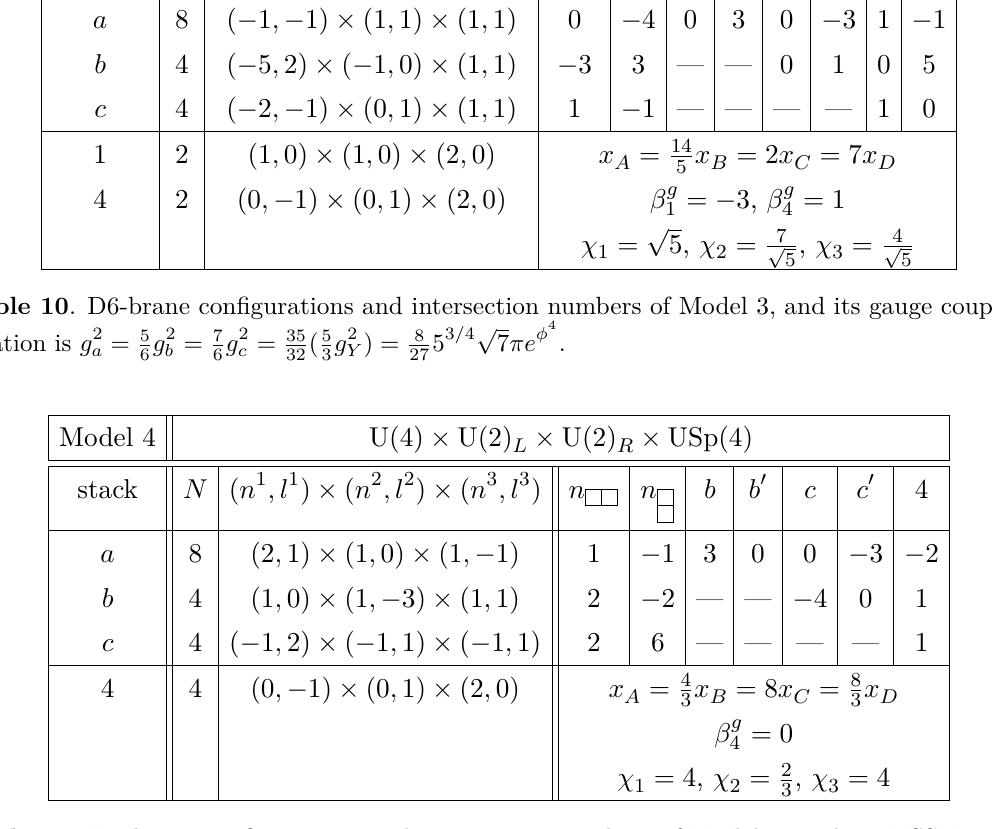
Table 11 . D6-brane configurations and intersection numbers of Model 4, and its MSSM gauge